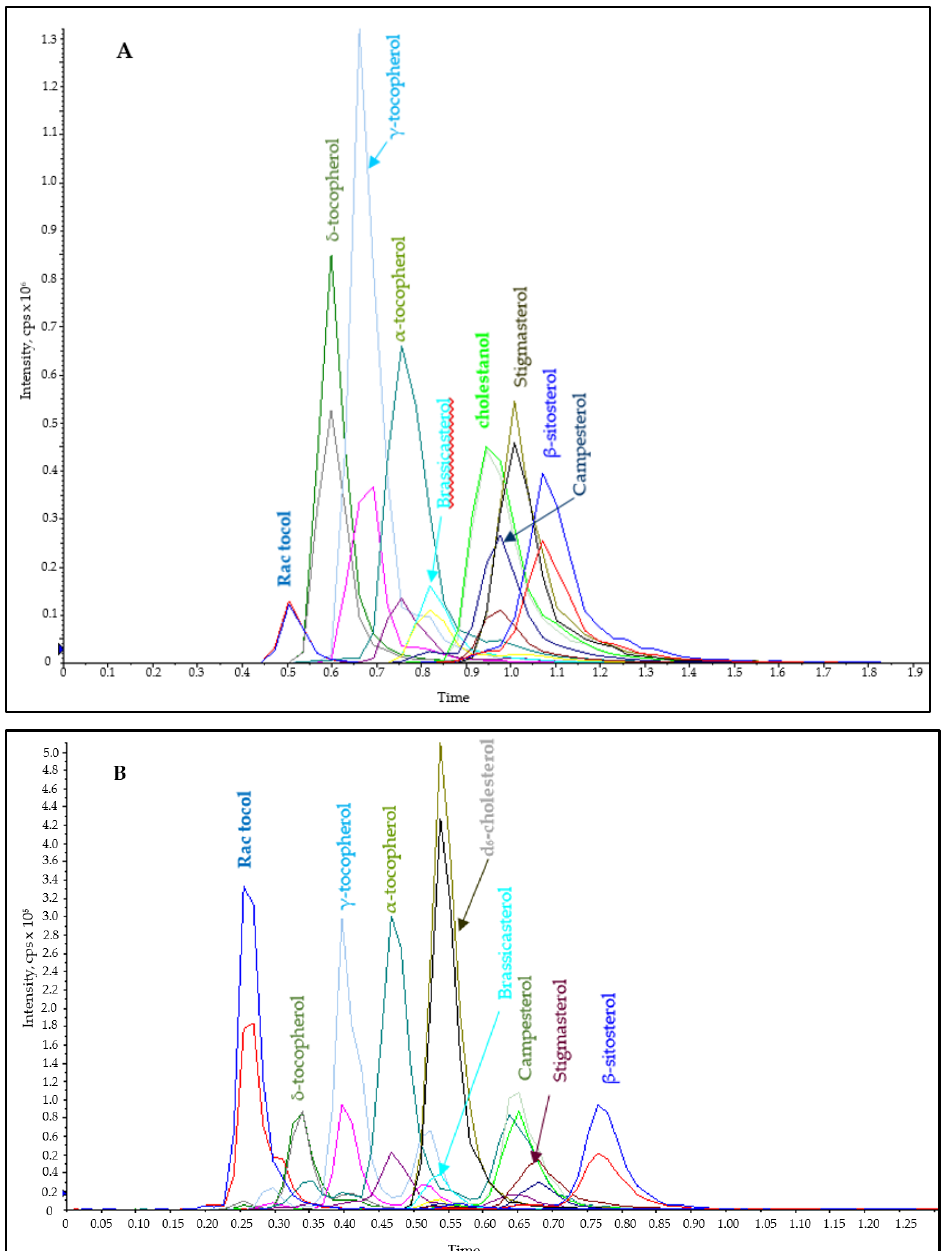
Figure 2. FC-MS/MS chromatogram of phytosterols and tocopherols on ( A ) 2.7 µ m guard column at 200 µ L/min and ( B ) 1.9 µ m guard column at 600 µ L/min. Better separation of analytes including the interfering ions was achieved by using 1.9 µ m guard